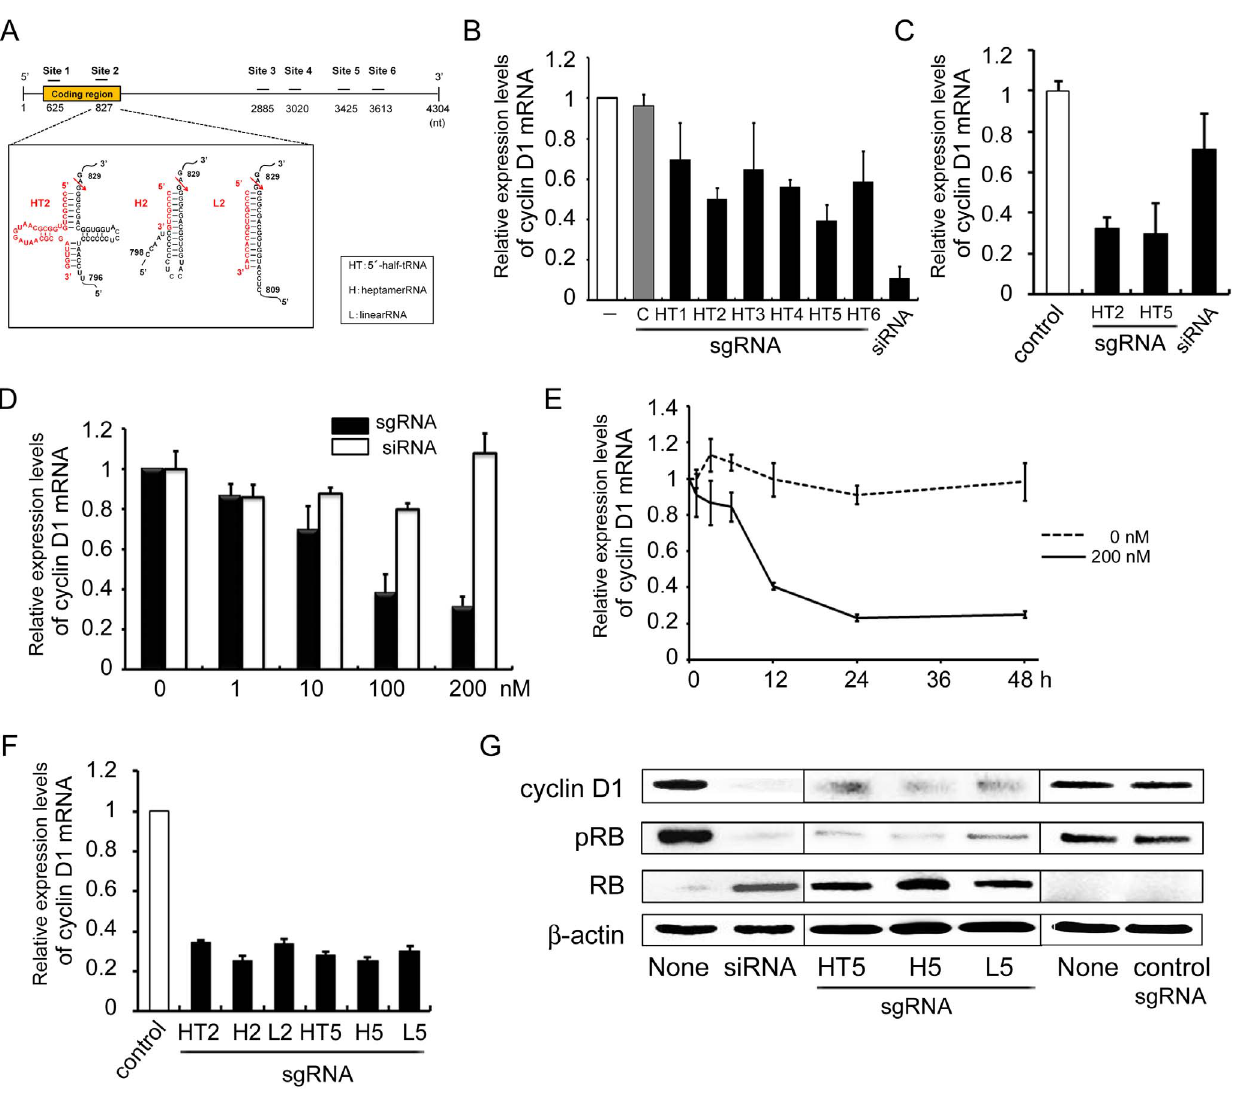
Figure 1. Design of an sgRNA targeting human cyclin D1 mRNA and the reduction in cyclin D1 mRNA and protein level by sgRNA. (A) Design of an sgRNA targeting human cyclin D1 mRNA. Secondary structures of sgRNA/target complexes between the sgRNA and the human cyclin D1 mRNA. Arrows indicate the expected tRNase ZL cleavage sites, with numbers at the cleavage sites from GenBank data ( # NM_053056.2). (B and C) Reduction in cyclin D1 mRNA level following sgRNA transfection. HSC-2 cells were plated at 1 6 10 5 cells/cm 2 , and then cultured for 24 h. (B) sgHT1–6 (200 nM), siRNA (10 nM), sgLucHep3 (C) (10 nM) or vehicle (-) was transfected with transfection reagent; (C) sgHT2 or sgHT5 (200 nM each), siRNA (10 nM) or sgLucHep3 (control) was treated without transfection reagent after which the cells were cultured for a further 24 h. Total RNA was extracted from the cells and the cyclin D1 mRNA level was determined by qRT-PCR. (D) Dose-dependent regulation of cyclin D1 mRNA expression. HSC-3 cells were plated and cultured as above. After 24 h, naked sgHT2 or siRNA was added at the indicated concentration. (E) Time-dependent regulation of cyclin D1 mRNA expression. HSC-3 cells were plated and cultured as above. After 24 h, naked sgHT2 was added at 0 (DASHED LINE) OR 200 nM (SOLID LINE) (E), and the cells were cultured for the indicated period. Cyclin D1 mRNA level was determined by qRT-PCR. (F) Effect of sgRNA subtype on the reduction of cyclin D1 mRNA expression. HSC-3 cells were plated and cultured as above. After 24 h, naked sgHT2, sgH2, sgL2, sgHT5, sgH5, sgL5 or sgLucHep2 (control) was added at 200 nM, after which the cells were cultured for 24 h. Cyclin D1 mRNA level was determined by qRT-PCR. (G) Regulation of the cyclin D1, RB and pRB protein level by sgRNA using western blot analyses. HSC-3 cells were plated and cultured as above. After 24 h, naked sgHT2, sgHT5, sgL5, sgLucHep2 (control) (200 nM each) or siRNA (20 nM) was added using no transfection reagent (sgRNA) or with Lipofectamine 2000 (siRNA), after which the cells were cultured for 24 h. The levels of cyclin D1, RB and pRB protein in the cells were determined by western blot analysis using appropriate antibodies. Blots were re- probed for b -actin as control. Each assay represents a separate experiment performed in triplicate. Data are presented as means ¡ S.D.